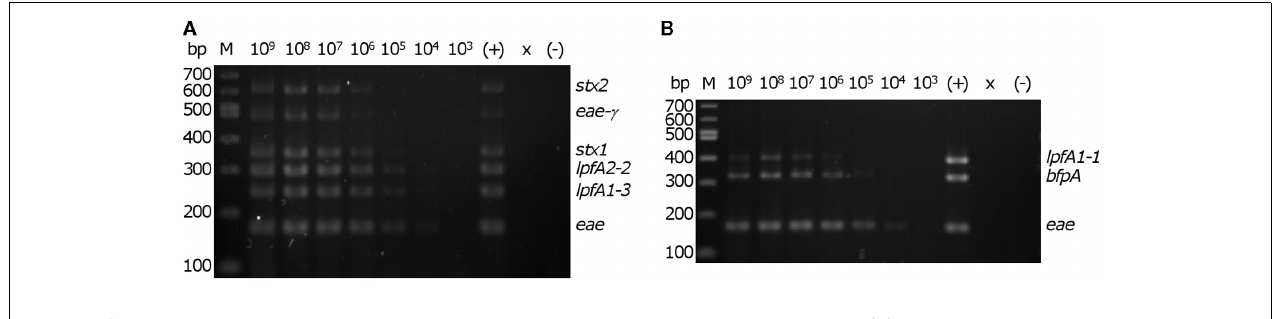
FIGURE 3 | Determination of detection threshold. Serial dilutions of re-suspended EHEC EDL933 or EPEC E2348/69 colonies were used as template in the multiplex PCR reaction. M – 100bp DNA markers (NEB). Number above each lane indicates the concentration (cells/ml) of bacteria per reaction. Consistent detection of (A) all of six EHEC